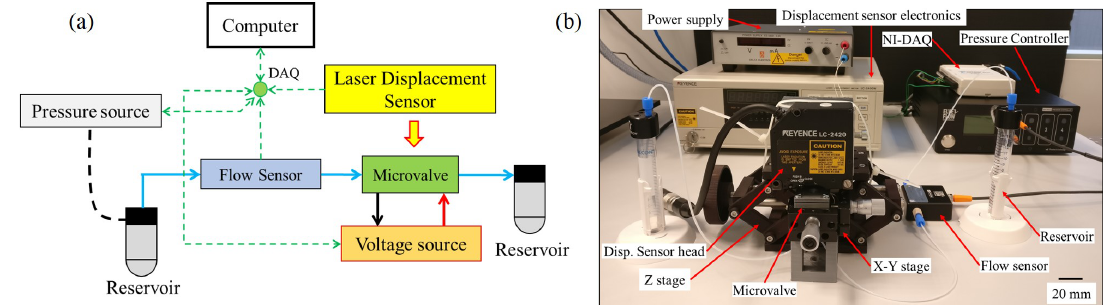
( a ) Schematic of the test set-up for measuring flow rate and displacement of the microvalve: Green dashed arrows are signal wires, red and black arrows are terminal wires of the microvalve, blue arrows are microfluidic tubing, and the black dashed line is tubing from the pressure source. Double-sided green arrows indicate information transmitted both ways. ( b ) Photograph of the